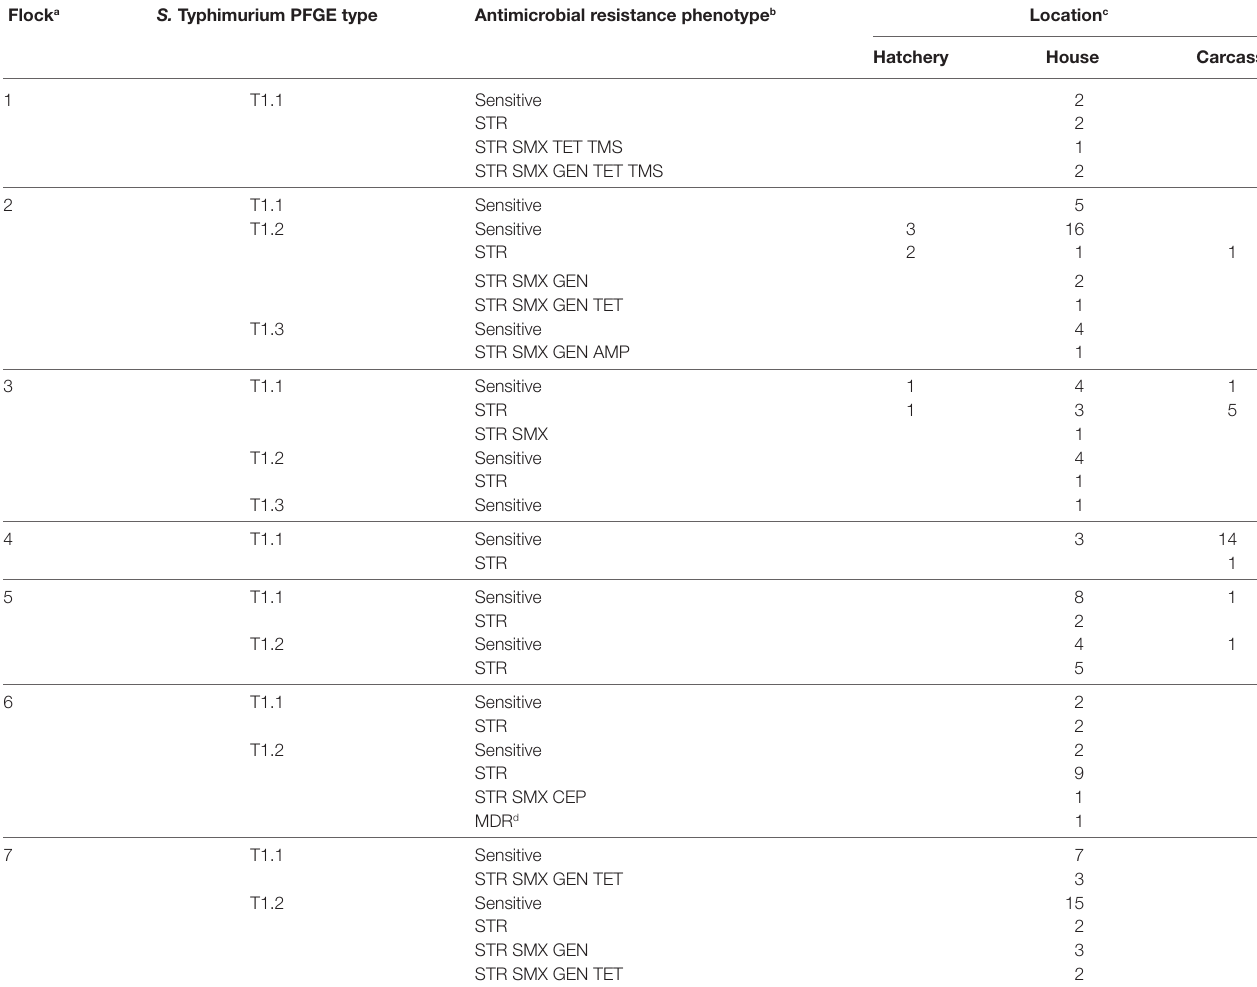
TaBle 4 | Temporal and spatial distribution of resident antibiotic susceptible and resistant S . Typhimurium strain types during the production of seven consecutive commercial broiler flocks. Flock